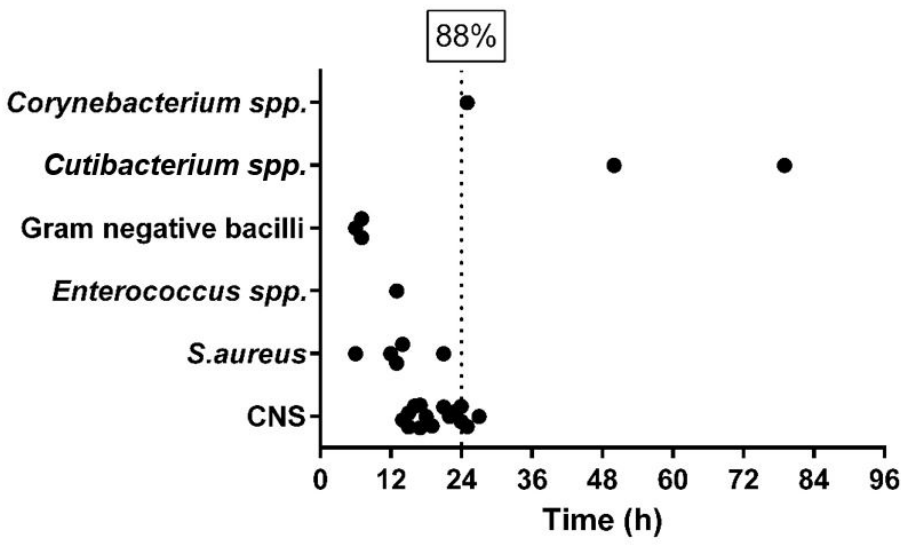
Figure 4. Direct turnaround time for direct pathogen identification by MALDI-TOF MS of positive BCB with sonication fluid (stratified to the type of pathogen).